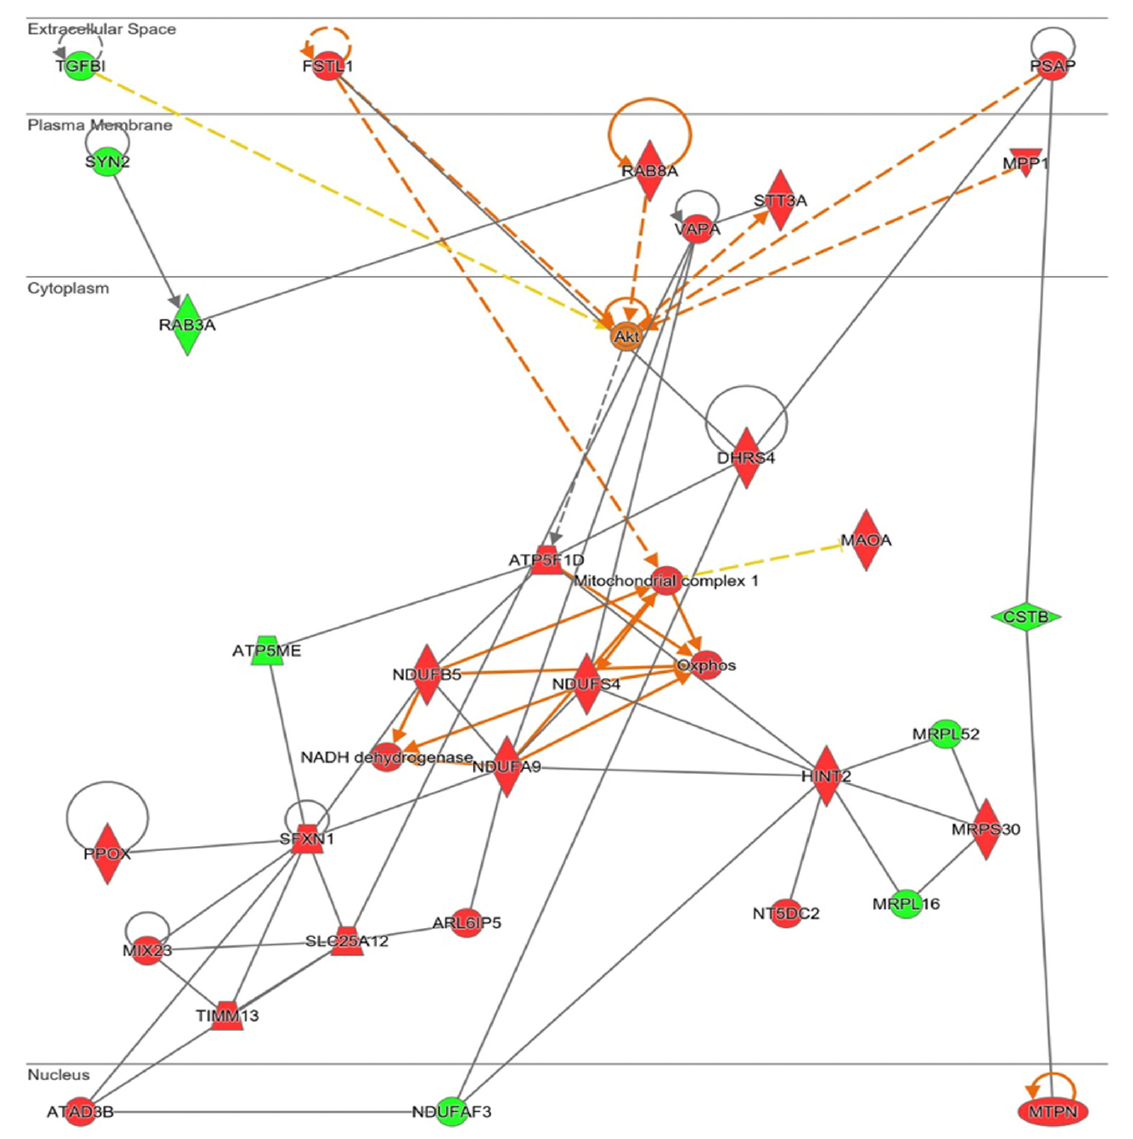
Figure 8. Network altered by NOX5- β overexpression in hCMEC/D3 cells related with metabolic alterations (inferred from Ingenuity ® software). Mitochondrial energetics dysregulation, including electron transport chain proteins upregulation. Proteins are represented in different subdivisions of the scheme according to their cellular location (nucleus, cytoplasm, plasma membrane, extracellular space, or other). Green: indicates decreased expression measurement. Red: indicates increased expression measurement. Orange lines: predicted activation. Grey/White lines: non-predicted effect. Yellow lines: findings inconsistent with the estate of downstream molecule. Color intensity directly associates with statistical confidence for orange and blue objects. Potential master regulators identified: Akt (activated).